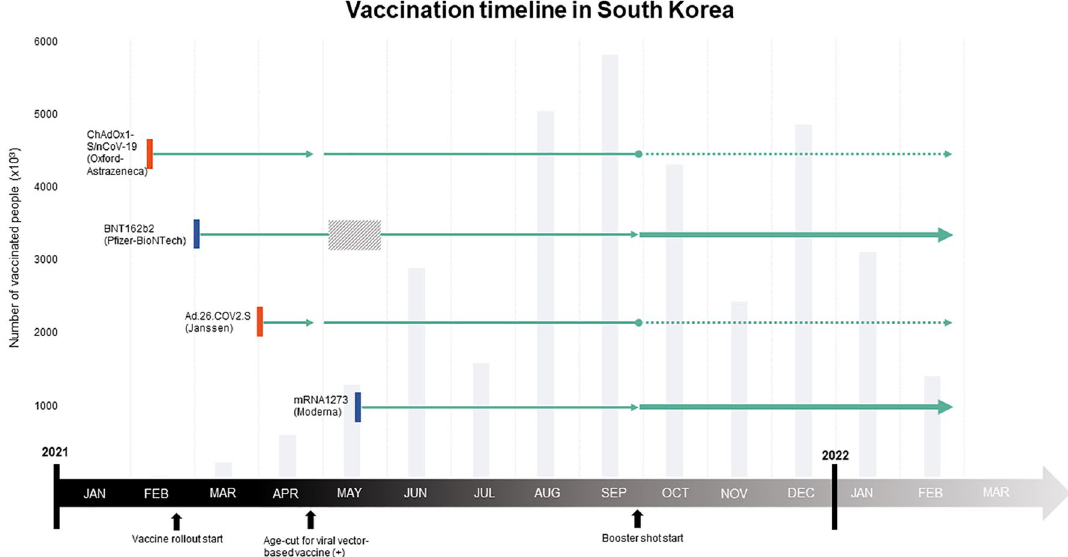
Figure 1. Vaccination timeline in South Korea; approval of four different types of vaccines; time-series of number of vaccinated people; and reported adverse events in the Gyeonggi province. A nationwide vaccination campaign for SARS-CoV-2 in South Korea was initiated on February 26th, 2021. Vaccines from four different manufacturers were approved: the viral vector-based ChAdOx1-S/nCoV-19 (Oxford-Astrazeneca) vaccine on February 10th, 2021; the BNT162b2 (Pfizer-BioNTech) vaccine on March 5th, 2021; the Ad26. COV2.S (Janssen) vaccine on April 7th, 2021; and the mRNA-1273 (Moderna) vaccine on May 21st, 2021. The initiation of each vaccine is represented by red and blue markers (red indicates mRNA-based and blue indicates viral vector-based). The slashed square area represents a temporary halt in the BNT162b2 vaccination in May 2021, owing to problems with vaccine supply. From the beginning of October, booster shots were given; most were mRNA vaccines (bold green line and arrow), and viral-vector vaccines (third dose of ChAdOx1-S/nCoV-19, an additional dose of Ad26.COV2.S) only represented a minority of vaccinated people (green dotted line and arrow). The gray bars in the background represent the total number of vaccinated people in the Gyeonggi province, South Korea, in the respective